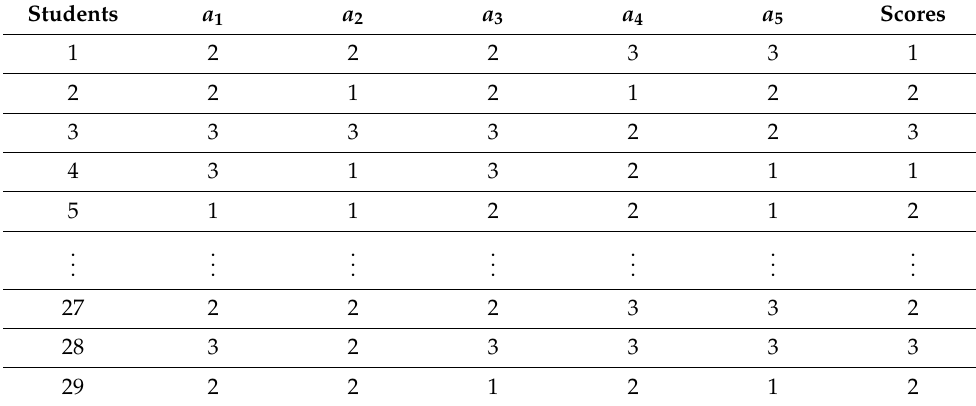
Table 2. The discrete of three